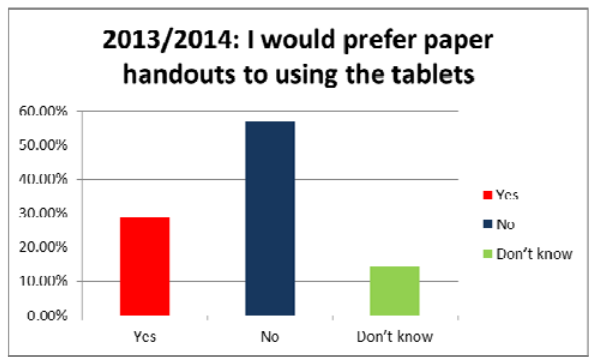
Figure 3. Digital vs. hardcopy handout preference by students